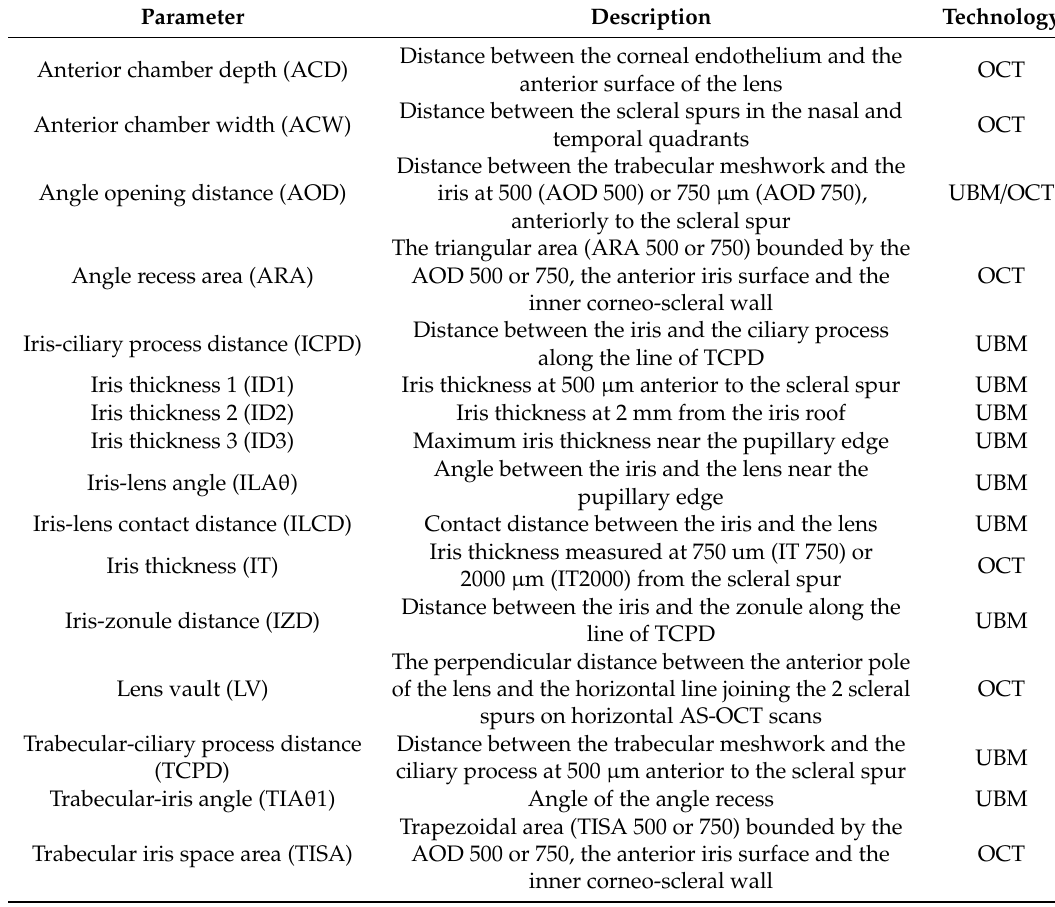
Table 1. Main quantitative parameters for the assessment of the anterior segment and the